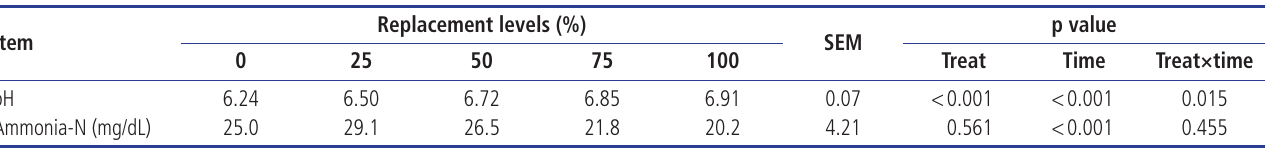
Table 5. Ruminal fermentation for steers fed cactus cladodes plus urea